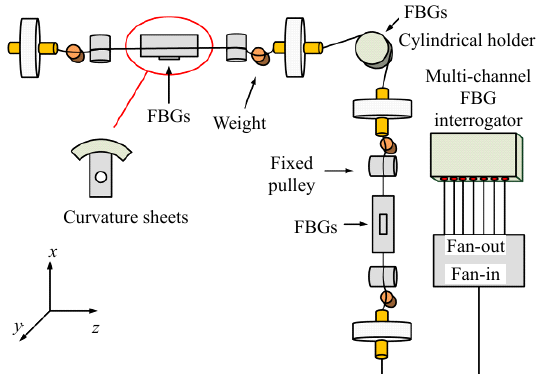
Fig. 6 Experimental setup for 3D curvature